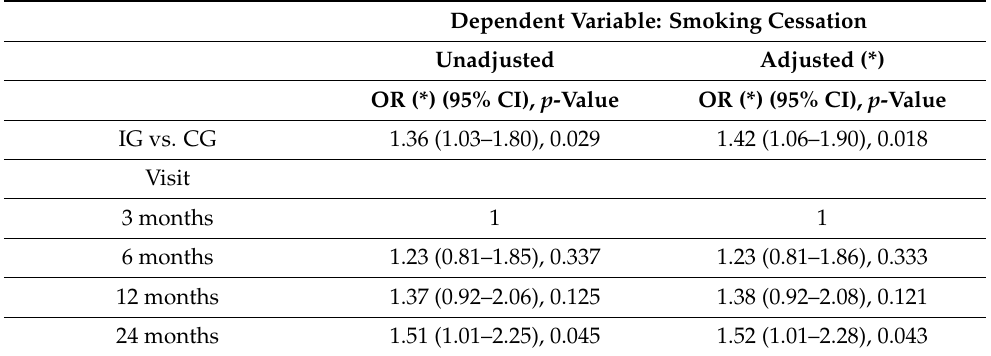
Table 5. Longitudinal logistic regression analysis of the effect of the intervention on smoking cessation. Dependent Variable: Smoking